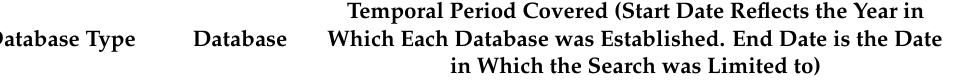
Table 1. Databases searched for the scoping review.